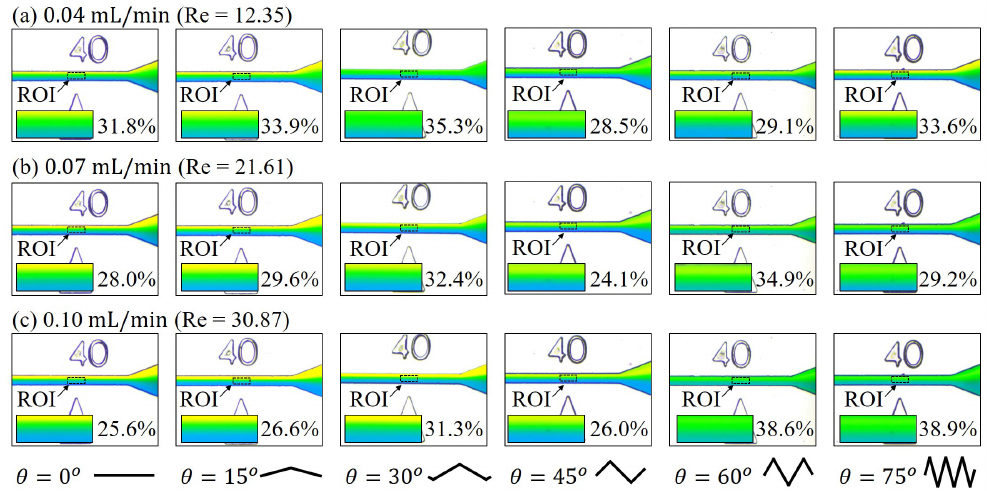
Figure 7. Experimental results of mixing with six different zigzag angles at medium flow